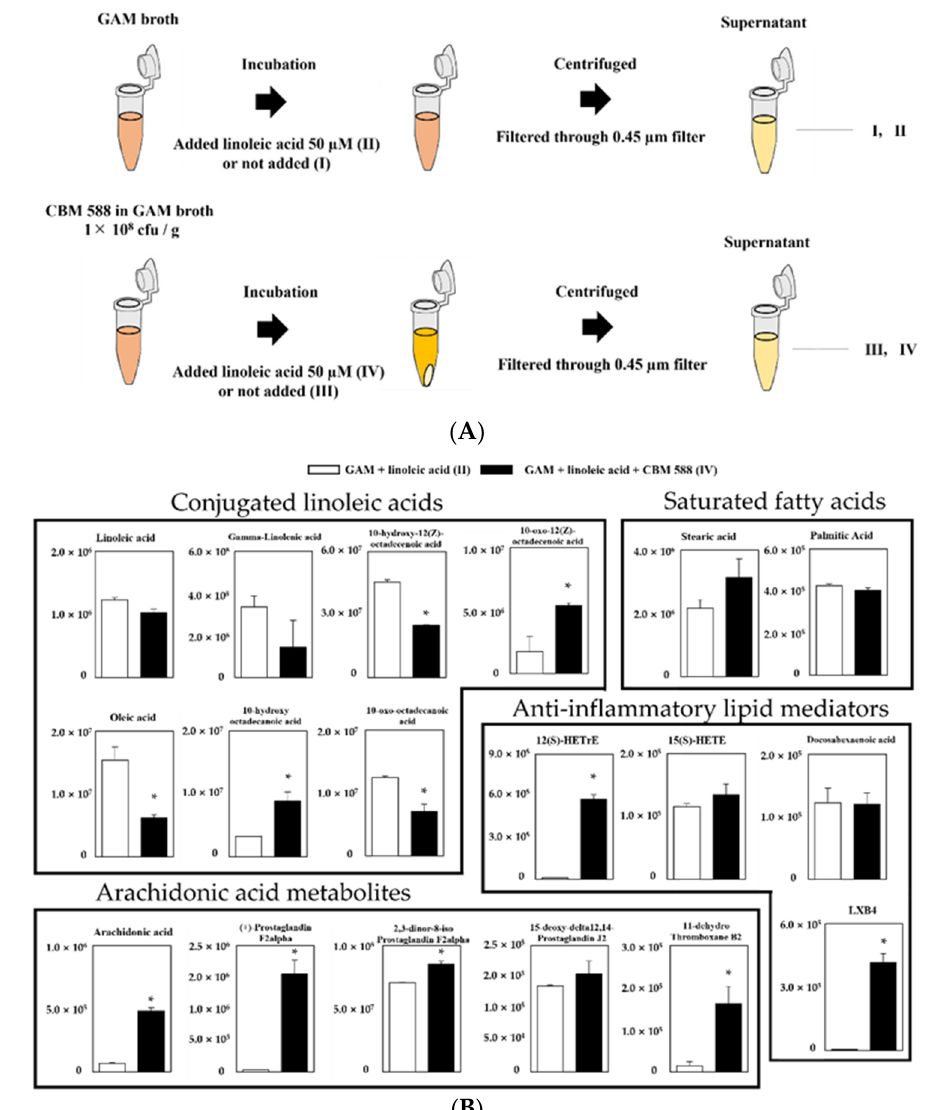
Figure 4. Evaluation of linoleic acid conversion during CBM 588 single-culture test based on target fatty acid metabolites profiles. ( A ) Experimental design of CBM 588 culturing. Culture broth were divided into four groups as follows, I: GAM broth, II: GAM-broth-containing linoleic acid 50 µM, III: supernatant after 24 h CBM 588 culture in GAM broth and IV: supernatant after 24 h CBM 588 culture in GAM-broth-containing linoleic acid 50 µM. ( B ) The metabolic pathway for the PUFAs in GAM broth culture medium (II and IV). The signal intensities of the metabolites were compared using the average value of each group. The vertical axis indicates the signal intensity. The values represent the mean ± SD ( n = 5). A probability was considered statistically significant at p < 0.05. *: p < 0.05 when compared with control.